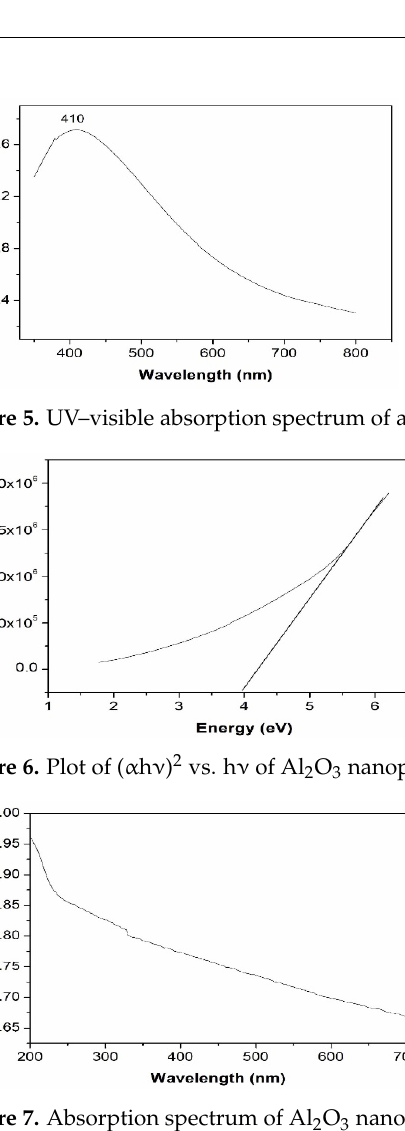
Figure 7. Absorption spectrum of Al 2 O 3 nanoparticles.